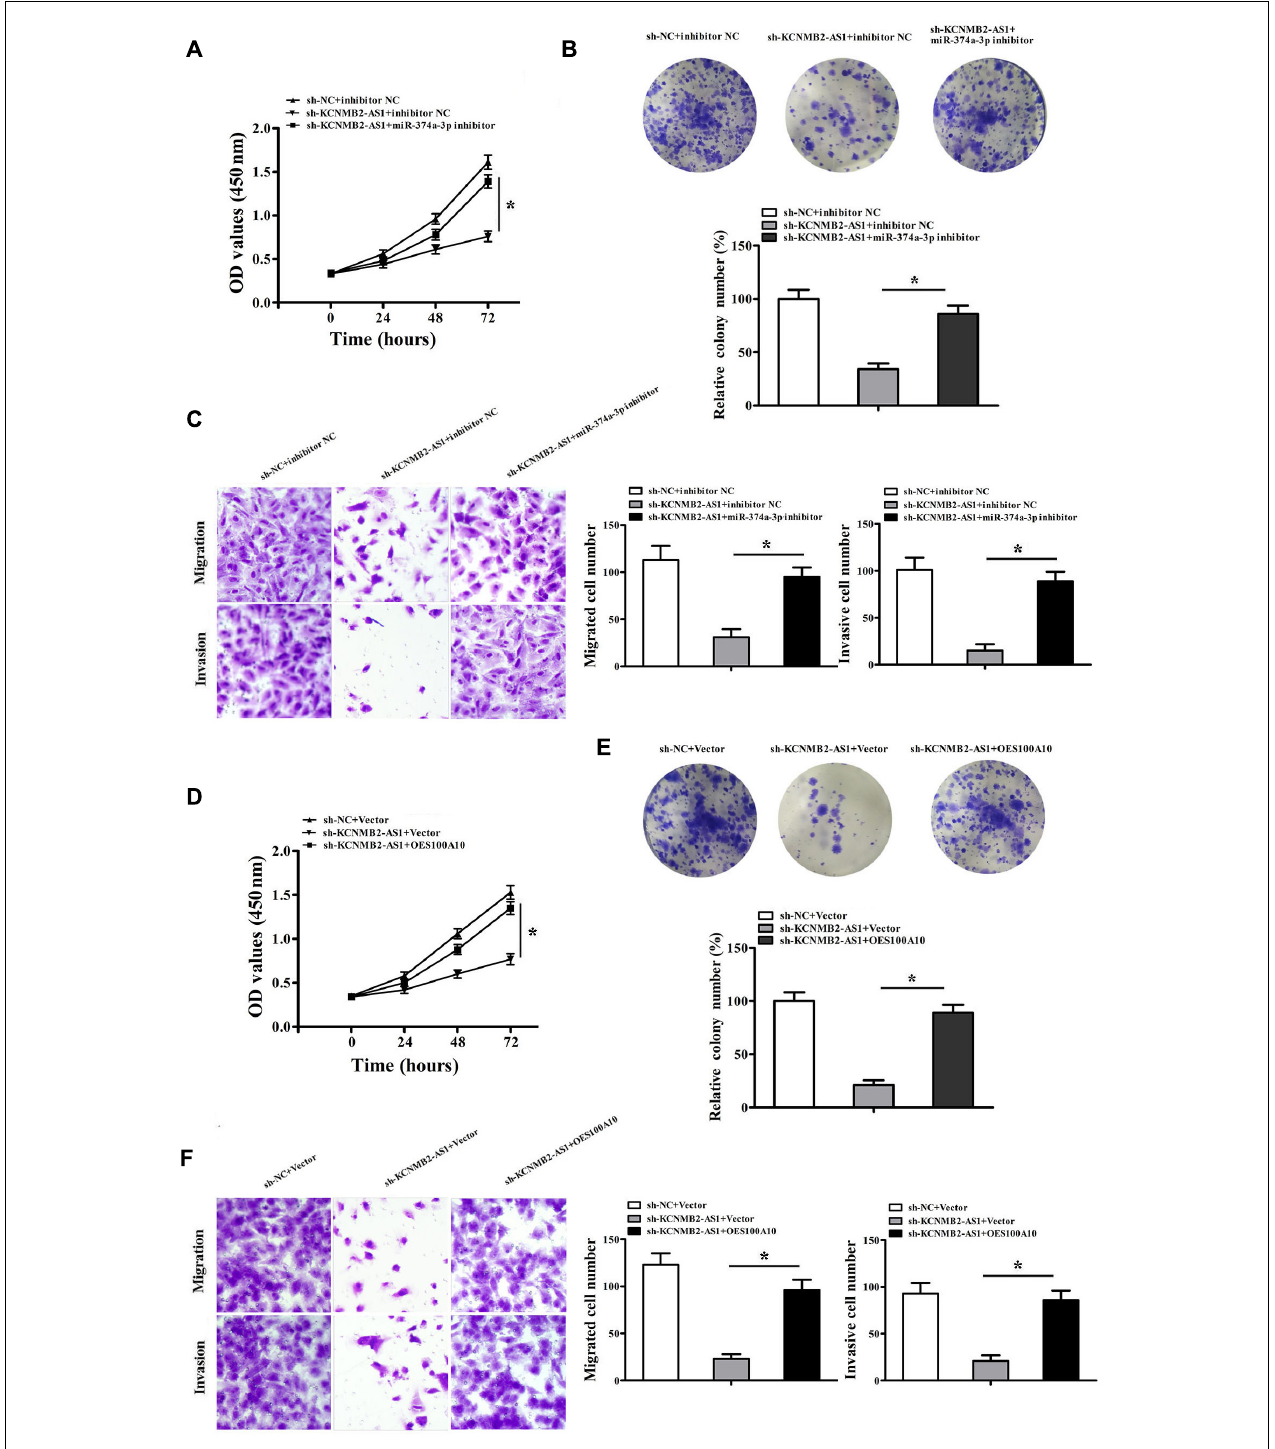
FIGURE 5 | KCNMB2-AS1 promoted BC progression through miR-374a-3p/S100A10 axis. T24 cells were transfected with sh-NC + inhibitor NC, sh-KCNMB2-AS1 + inhibitor NC or miR-374a-3p inhibitor + sh-KCNMB2-AS1. (A,B) CCK8 and colony formation assay were performed. (C) Migration and invasion assay was performed. T24 cells were transfected with sh-NC + Vector, sh-KCNMB2-AS1 + Vector, sh-KCNMB2-AS1 + (overexpression, OE) OES100A10. (D,E) CCK8 and colony formation assay was performed. (F) Migration and invasion assay was performed. Data were shown as mean ± standard deviation. The experiment was repeated three times. * P <